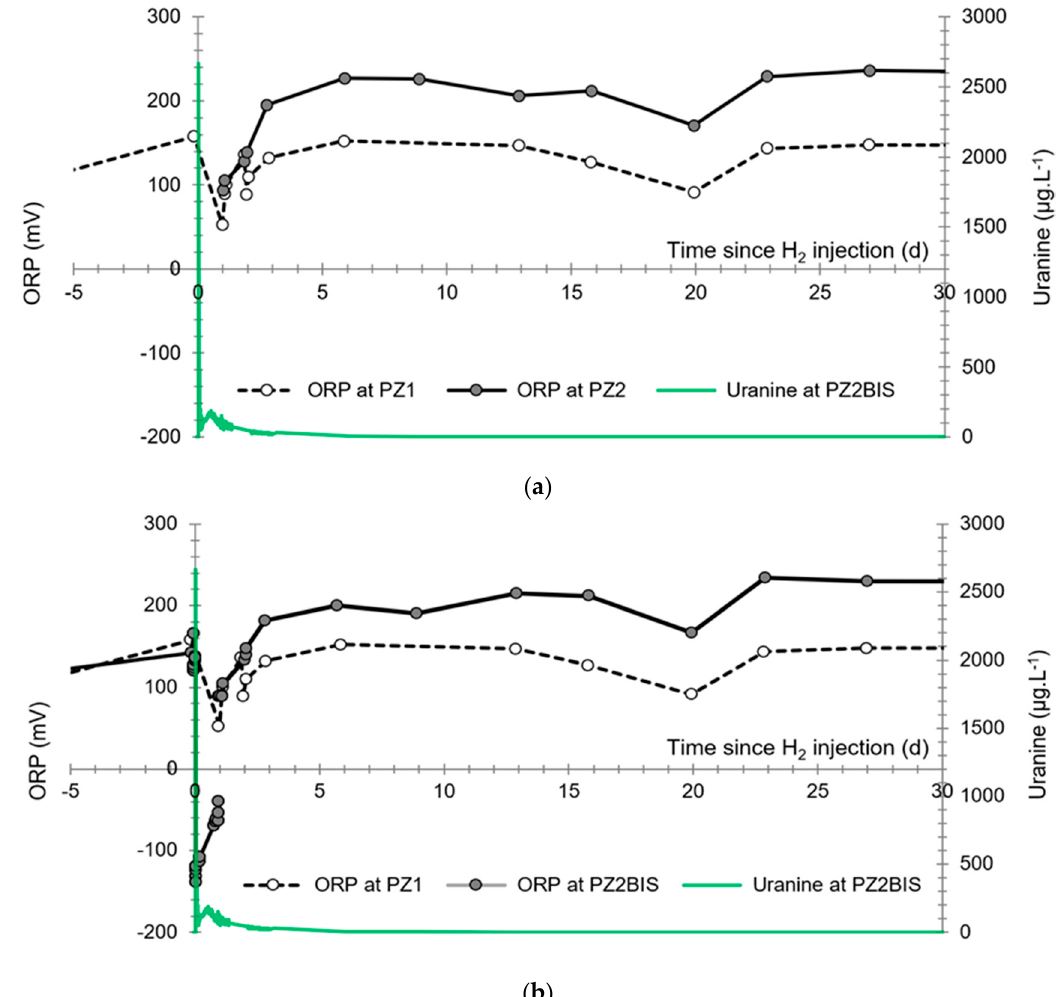
Figure 14. Comparative evolution of the oxidation-reduction potential and the tracer concentration at PZ1 (20 m upstream), PZ2 (injection well), and PZ2BIS (5 m downstream): ( a ) PZ1 and PZ2; and ( b ) PZ1 and PZ2BIS. The gap in the redox potential values corresponds to the change of probe.